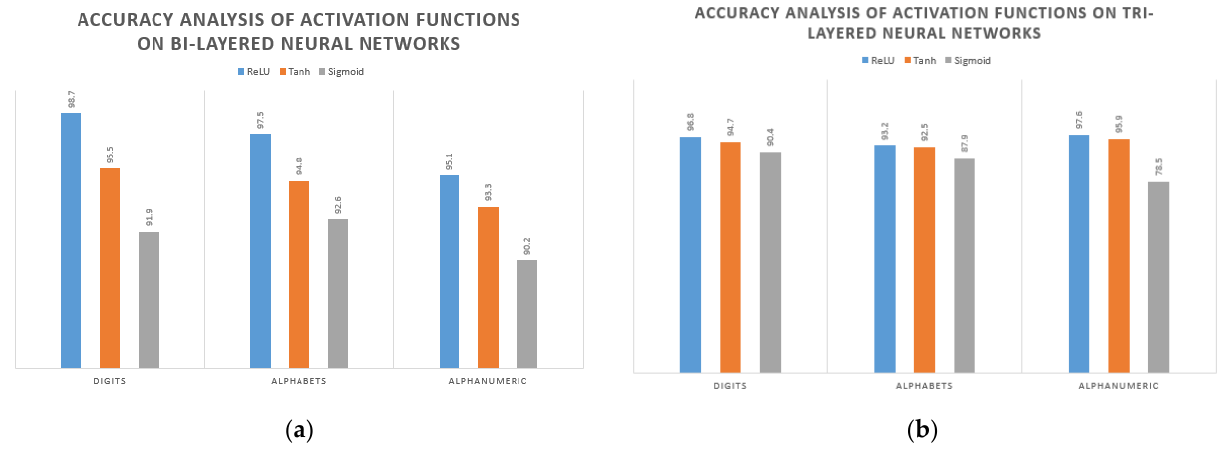
Figure 7. Activation function impact on the accuracy of the neural